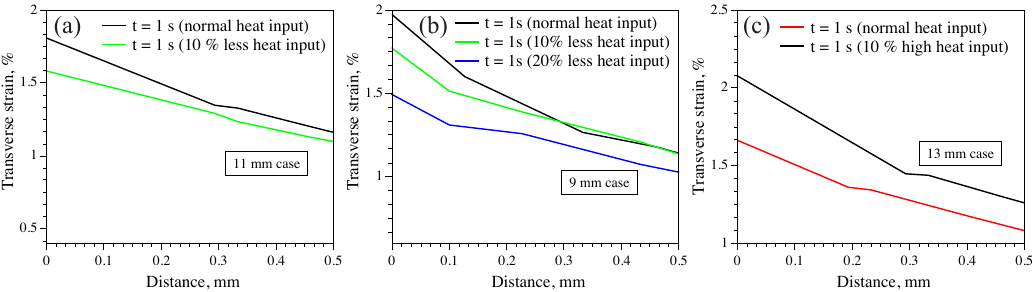
Figure 13. Effect of heat input on the transverse strain along L1 at t = 1s. ( a ) The 11 mm case with normal and 10% less heat input, ( b ) 9 mm case with normal and 10% and 20% less heat input and ( c ) 13 mm case with normal and 10% high heat